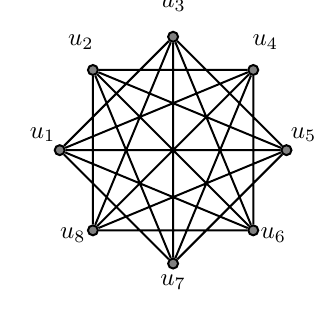
Figure 10: The graph C